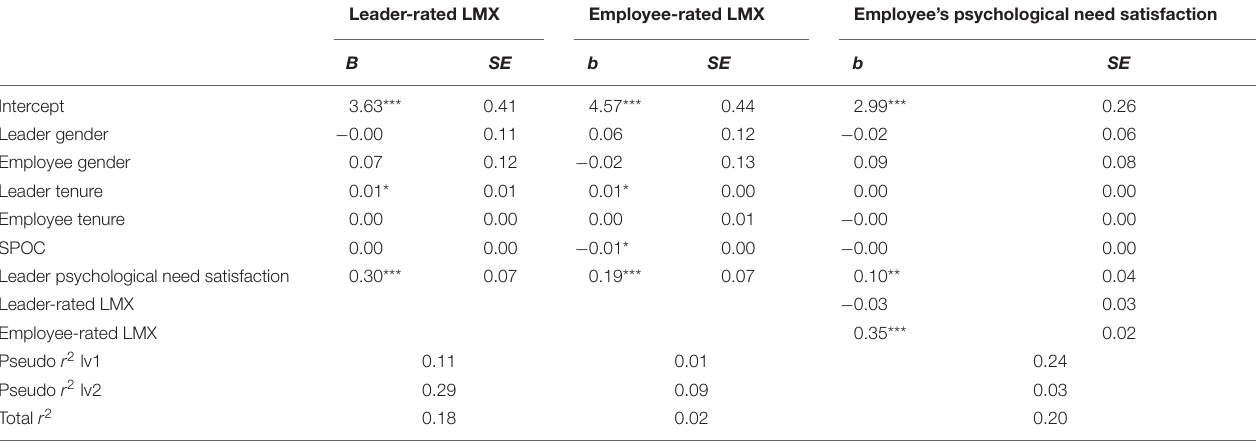
TABLE 3 | Hierarchical regression results for the final model.